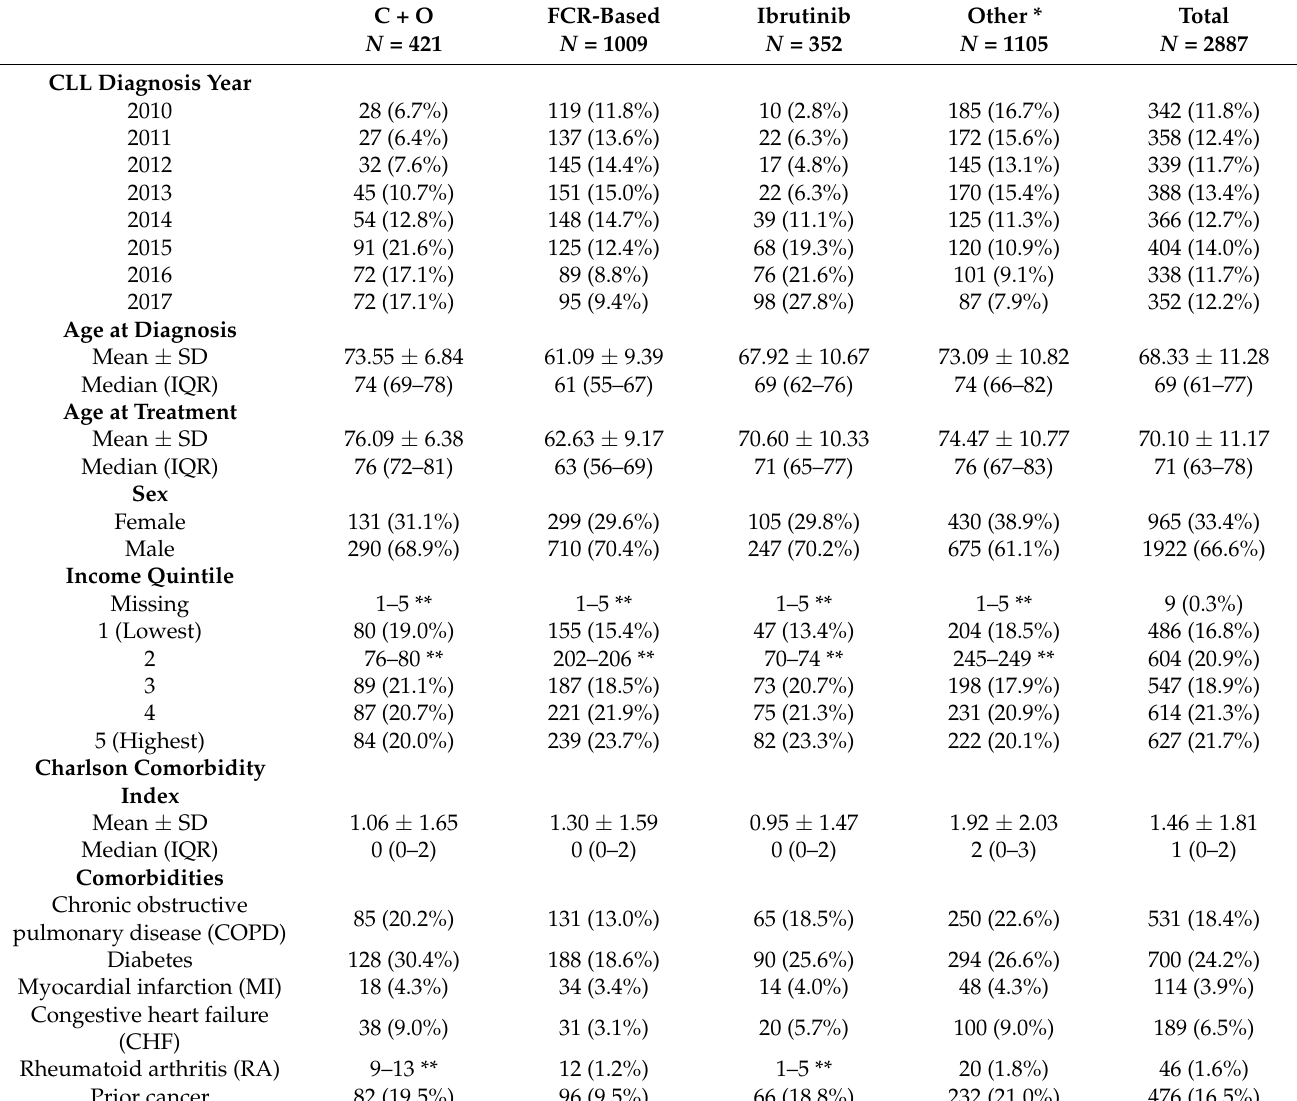
Table 1. Demographic table of treated patients diagnosed with CLL in Ontario between January 2010 to December 2017 stratified by treatment regimen